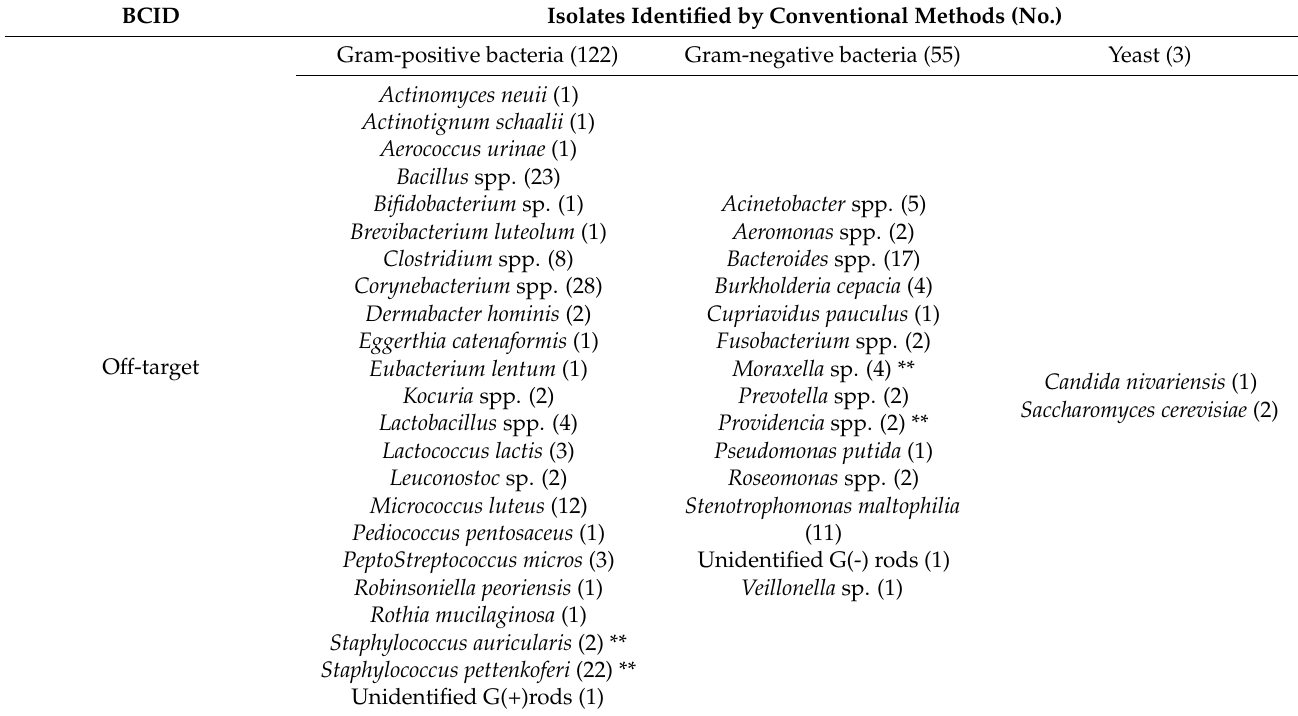
Table 4. BCID off-panel organisms identified by conventional methods. Isolates Identified by Conventional Methods